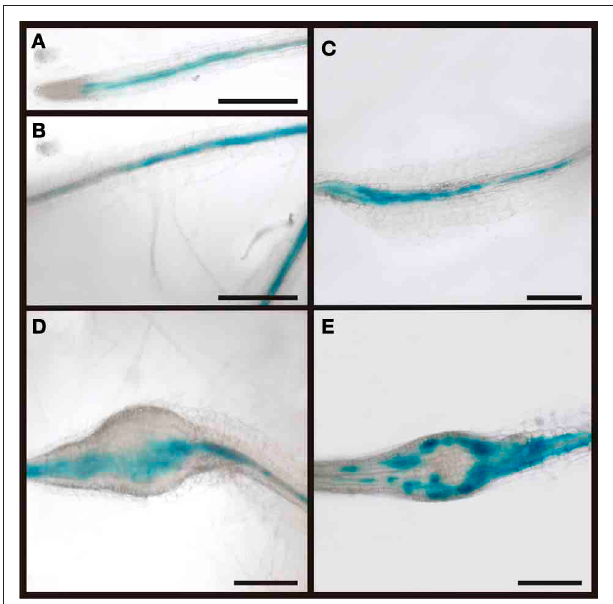
FIGURE 7 | Activity of the RS6 promoter visualized by GUS staining in P RS 6 :GUS plants. In control sections of plants roots infected with M. incognita staining is observed throughout the stele (A,B) . In root knots 5dai the staining is still limited to the stele (C) . In root-knots 10dai the staining is spreading out but still in the position of the original phloem pole (D) . In mature root-knots (E) , 17dai, staining is observed around the giant cells. Scale bars represent 200 µ m.